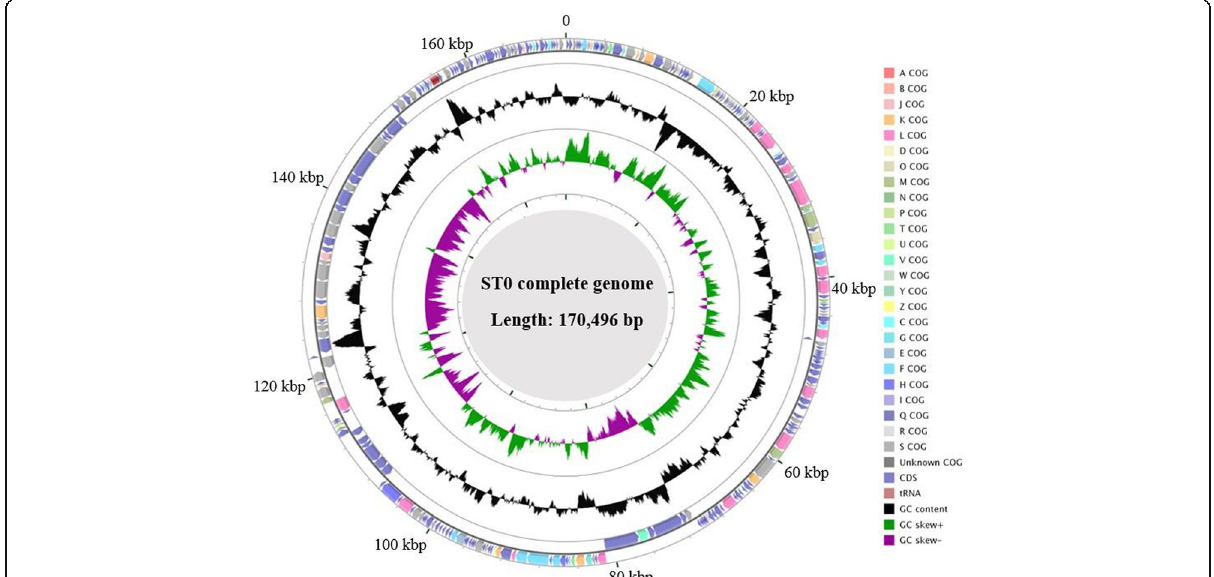
Fig. 3 CGView Server map of phage ST0 complete